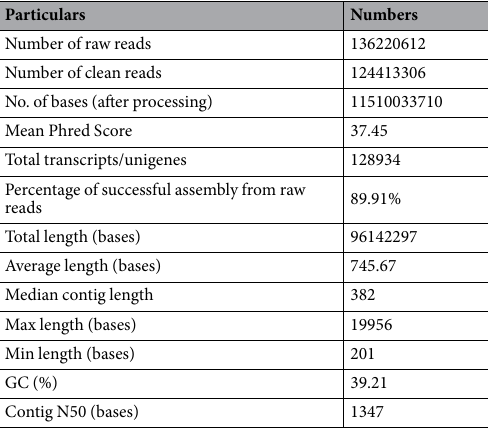
Table 1. Summary of Illumina paired-end sequencing and de novo assembly of Solanum trilobatum